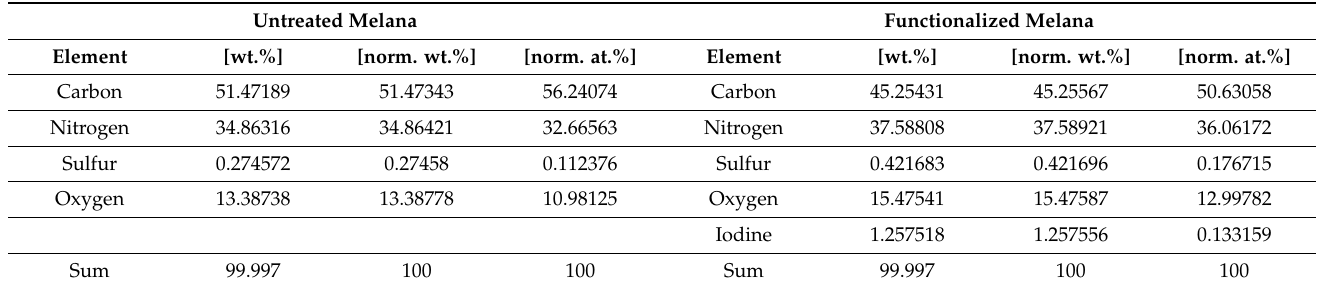
Table 4. Elemental composition of Melana fibers before and after